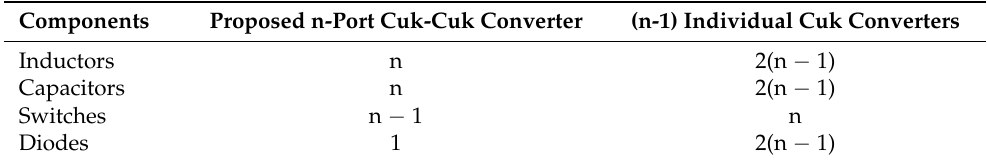
Table 2. Comparison of components in [35].